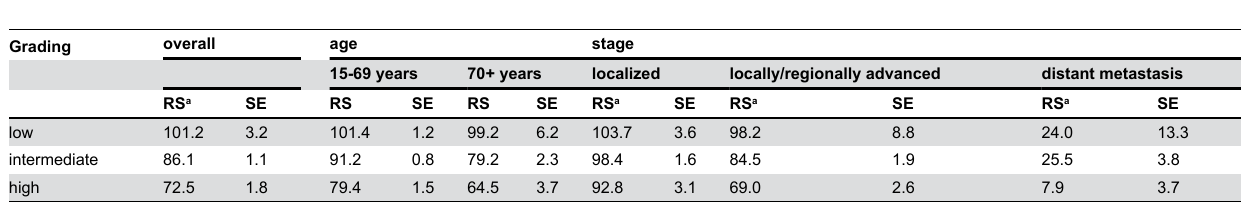
Table 4. Five-year relative survival of female patients from Saarland with invasive breast cancer (ICD-10 code: C50) by tumor grade and stratified by age and stage estimated for the calendar period 2005-2009 based on completed datasets.